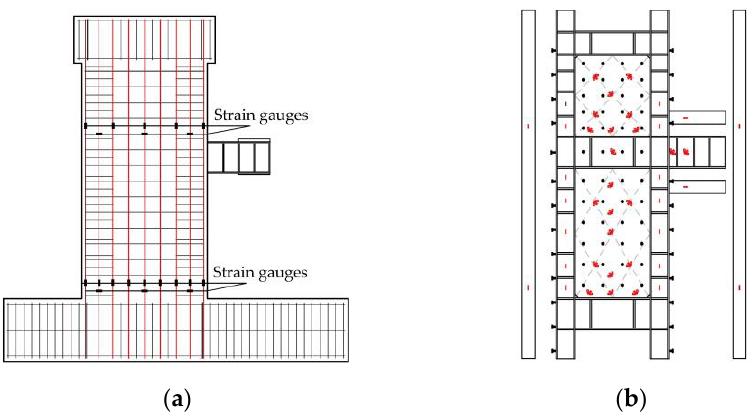
Figure 10. Layout of LVDTs and LPs.